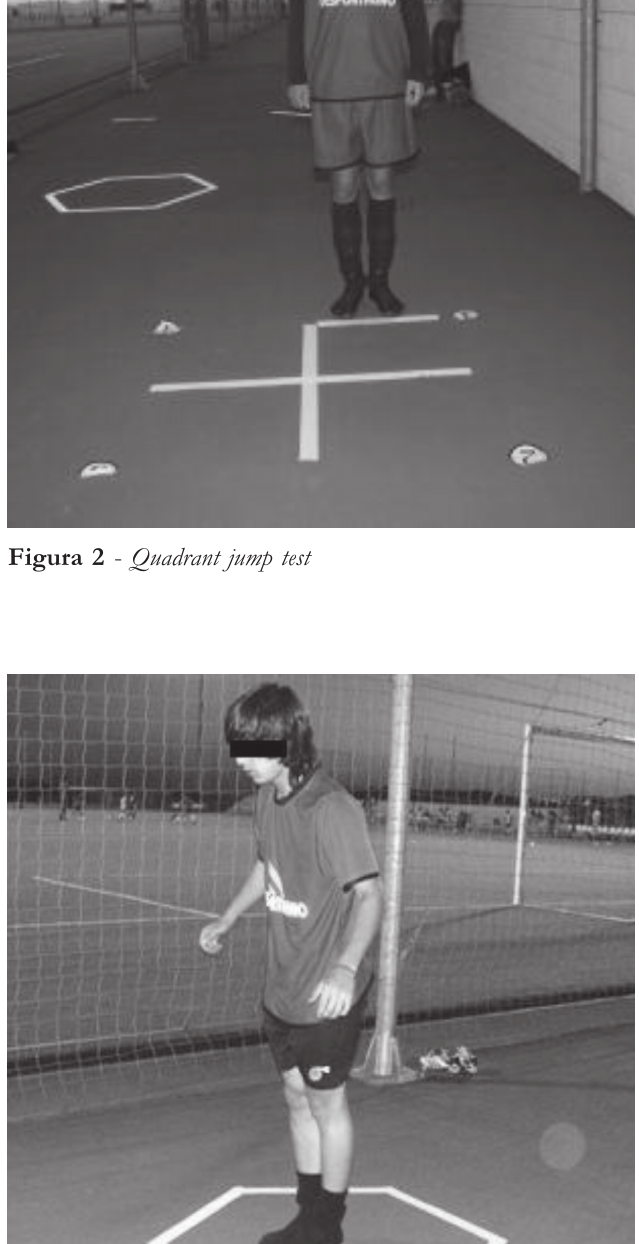
O Quadrant Jump Test (Figura 2) foi